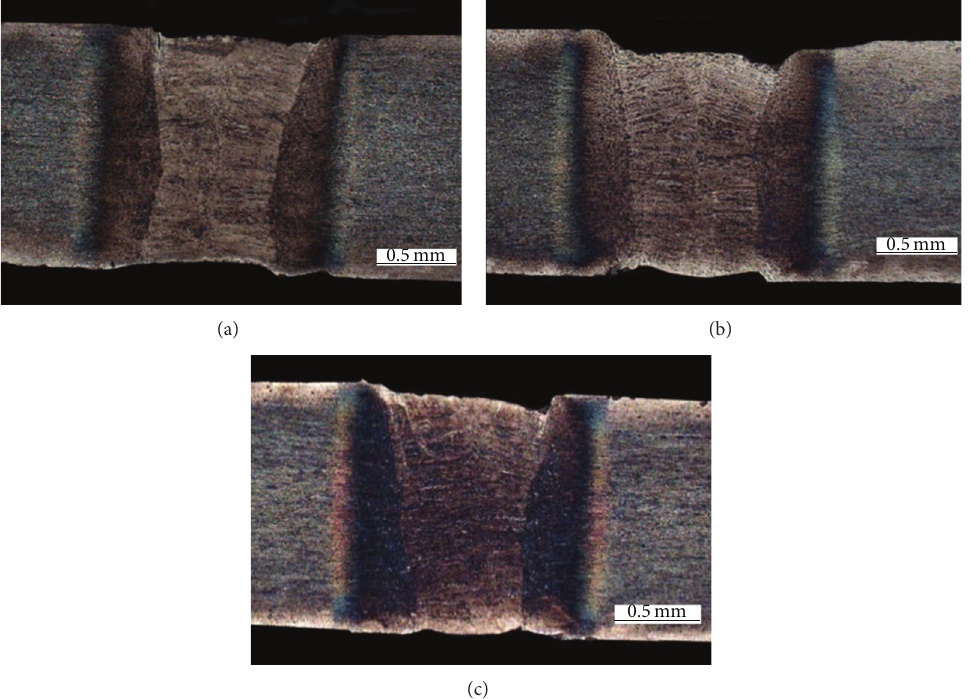
Figure 3: Macrostructure of penetration areas made with process heat input of 0.051kJ/mm (a); 0.043 kJ/mm (b); 0.037 kJ/mm (c).